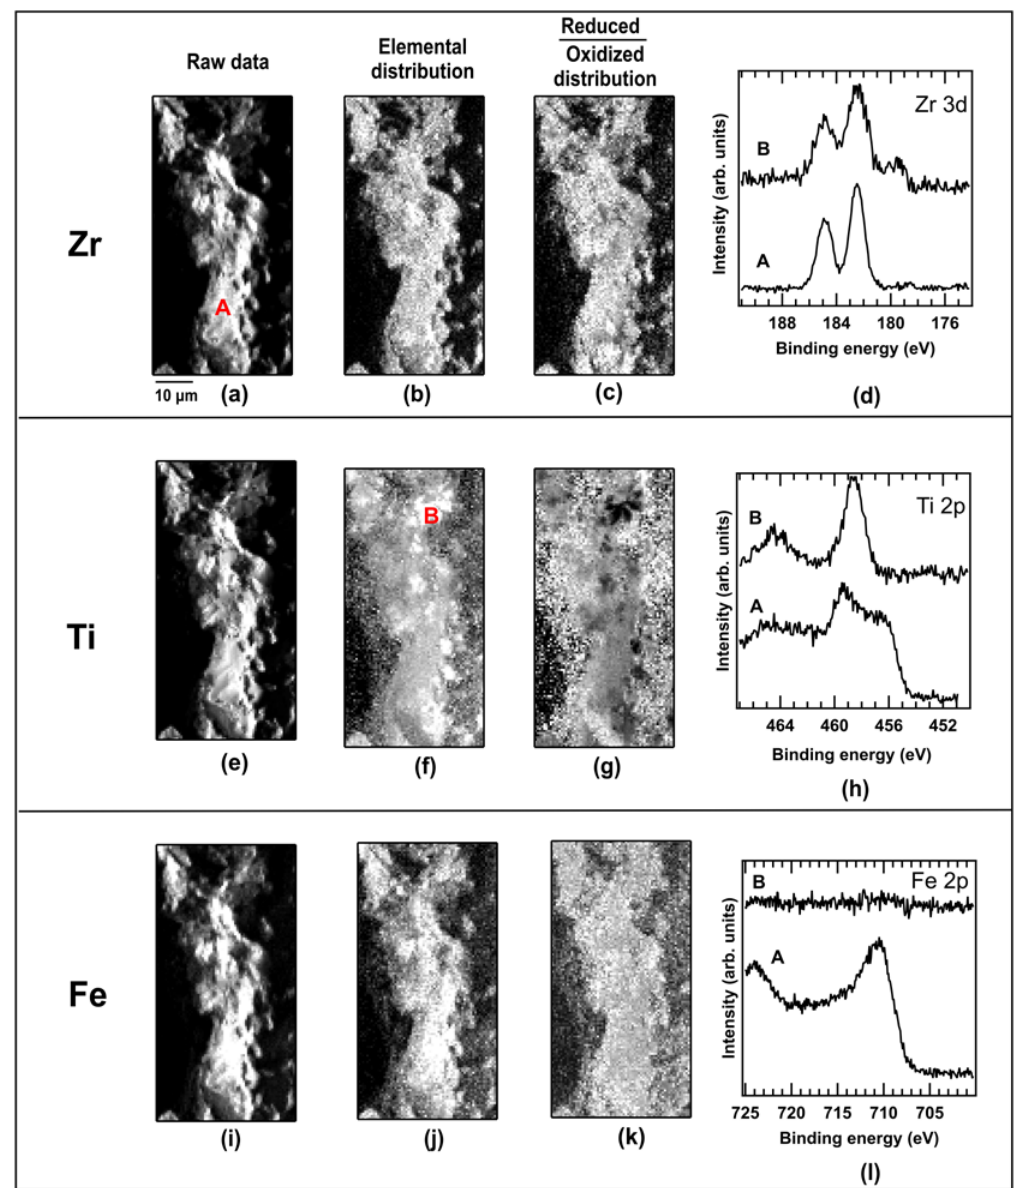
Figure 4. Element distribution and spectra of Ti, Fe and Zr in as-cast TiFe + 4 wt.% Zr. Zr ( a – d ), Ti ( e – h ), Fe ( i – l ). Raw data: ( a , e , i ), Elemental distribution ( b , f , j ). Reduced/oxidized distribution ( c , g , k ). Spectra ( d , h , l ).